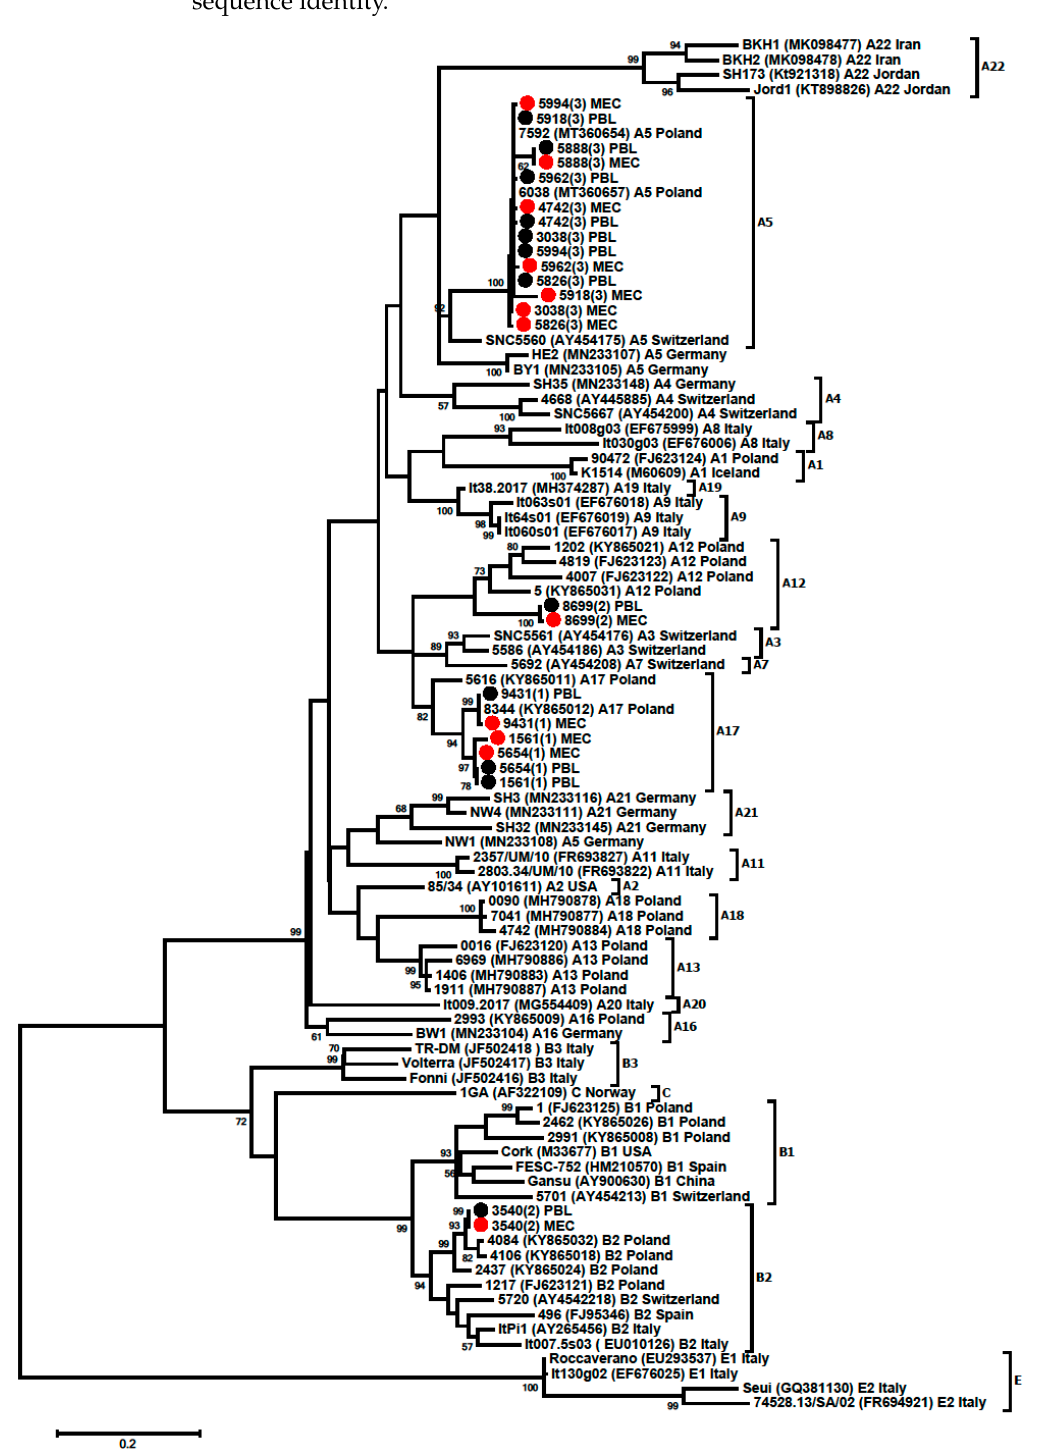
Figure 2. Maximum likelihood phylogenetic tree based on gag sequences of SRLV isolates. In the present study, the SRLV subtypes found by Colitti et al. [25] were renamed from A18 to A19 and from A19 to A20. SRLVs sequences isolated from goats examined in this study are indicated with filled circles: red color-milk epithelial cells (MEC), black color-peripheral blood leukocytes (PBLs) followed by the flock origin (1–3). The reference sequences are indicated by name and their GenBank accession number between brackets followed by the subtype and country origin.